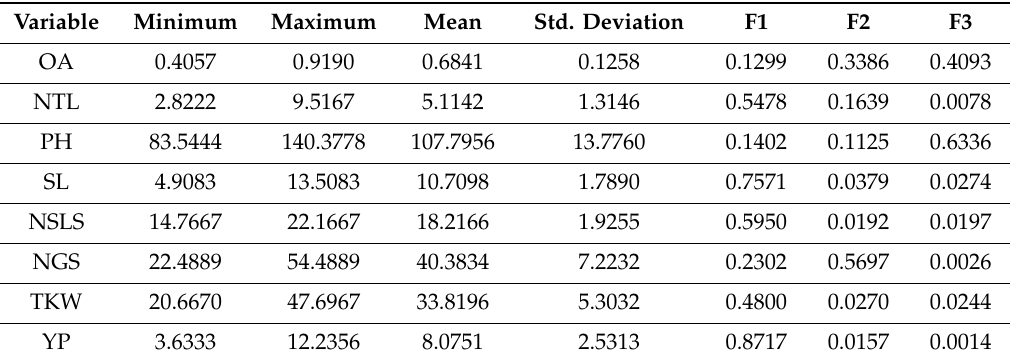
Table 3. Summary statistics and principal component squared cosines values (last 3 columns) for all